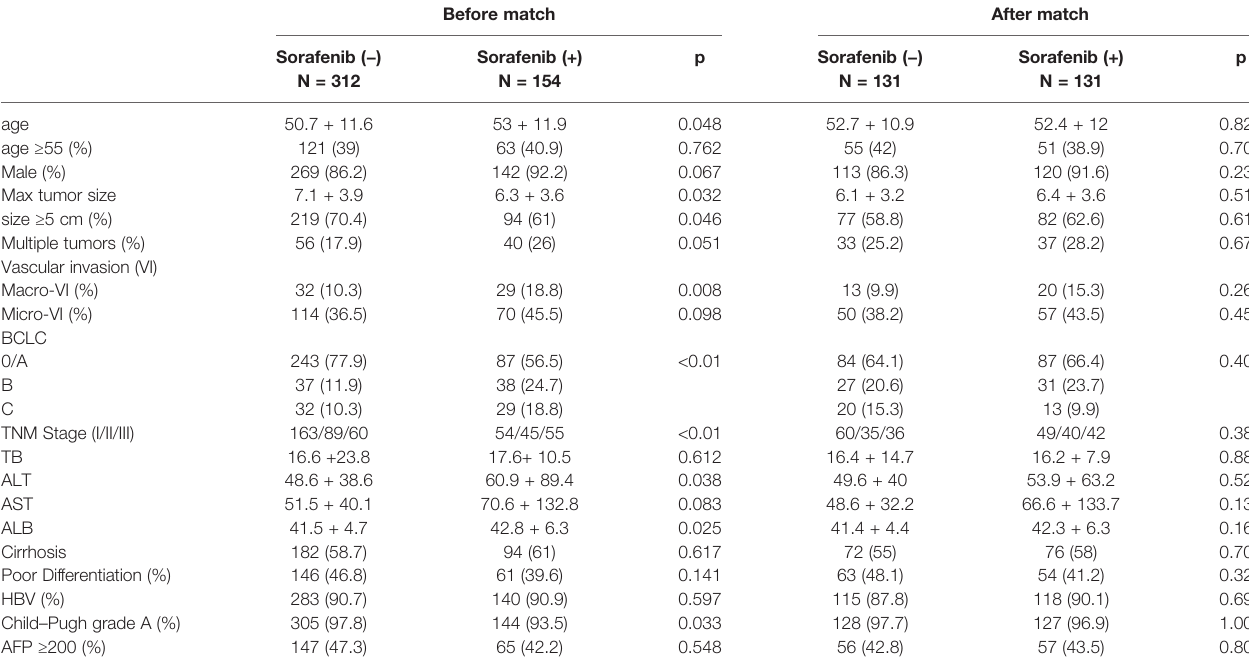
TABLE 1 | Characters of patients concerning postoperative sorafenib therapy before and after PS match. Before match After match Sorafenib ( − ) Sorafenib